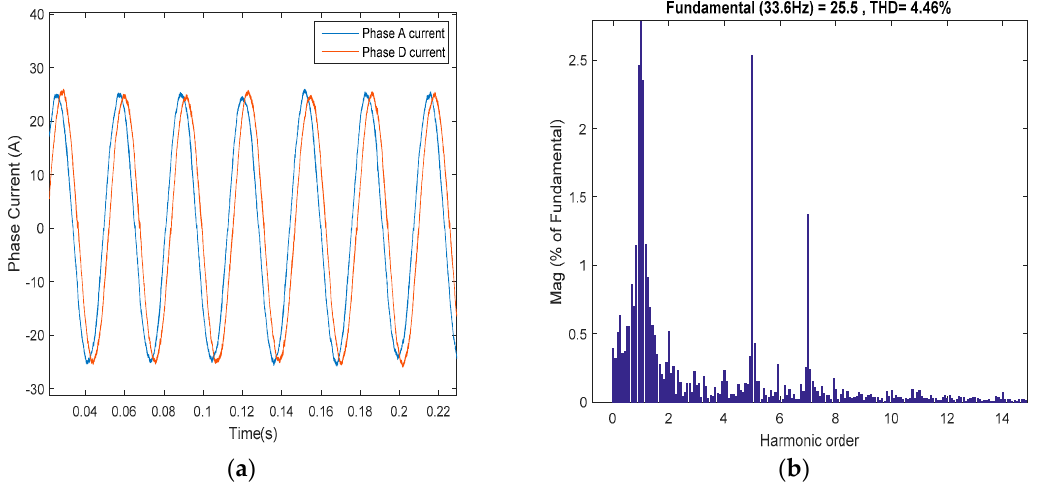
Figure 15. Experimental results after adopting the ADALINE-based voltage compensator when the motor speed is 500 rpm, ( a ) Phase A and D currents and ( b ) THD for phase A current.